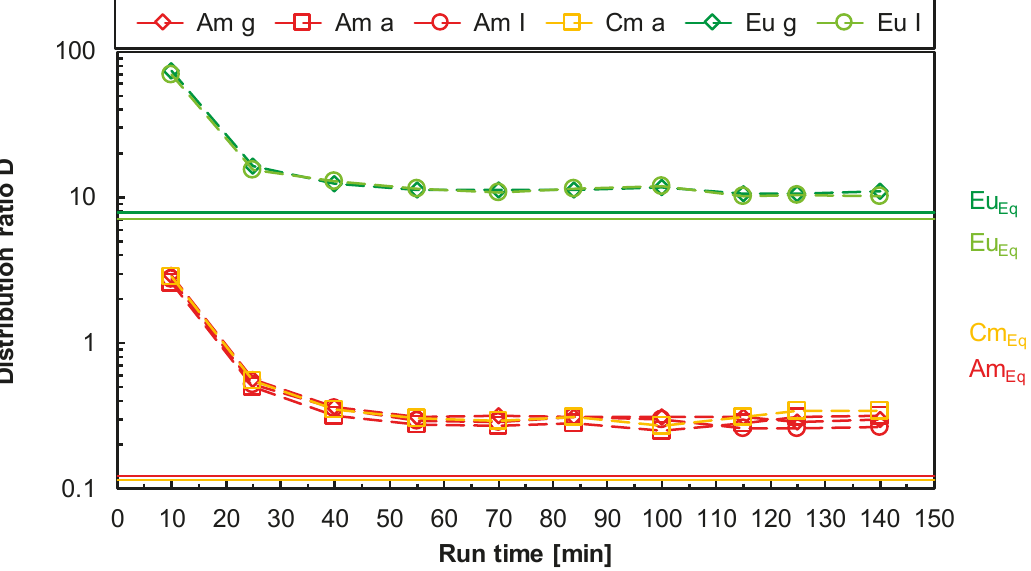
Figure 4. Am, Cm, and Eu distribution ratios as a function of the experimental run time (data points) and equilibrium values (horizontal lines) in the An stripping section single centrifugal contactor test. “g”, “a”, and “I” indicate values measured by gamma and alpha spectrometry as well as ICP-MS,